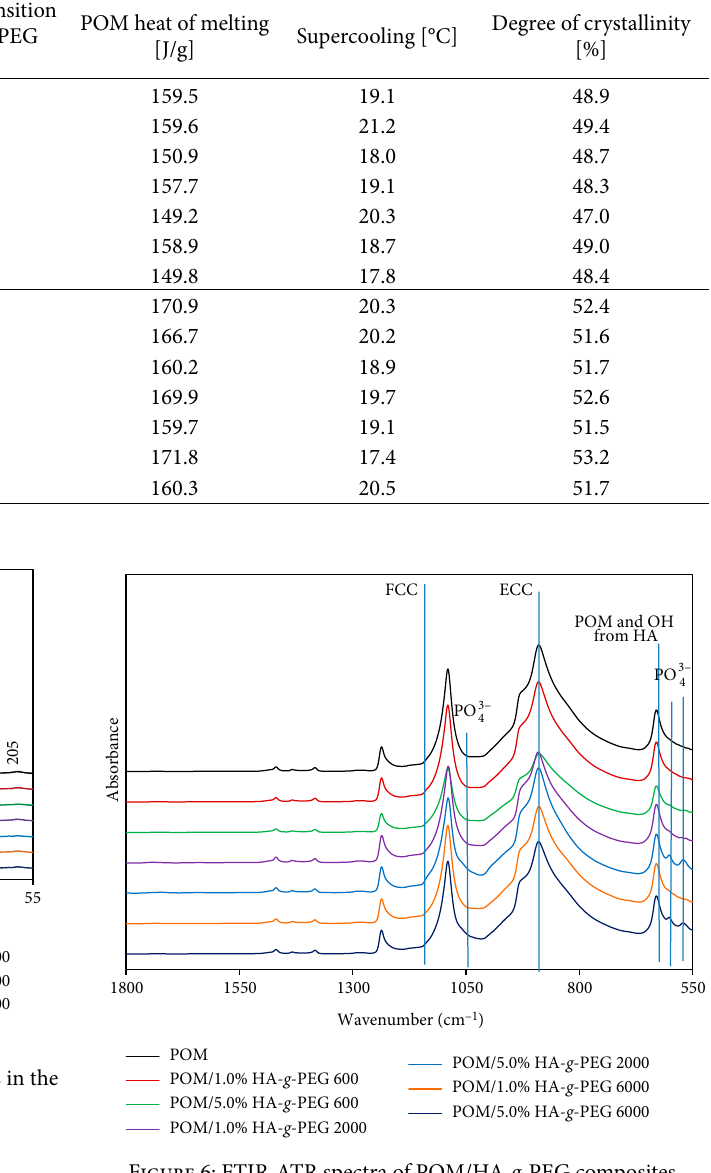
Table 4: Temperature, heat of melting, supercooling, and degree of crystallinity of POM/HA- g -PEG composites (during first heating and second heating cycles).